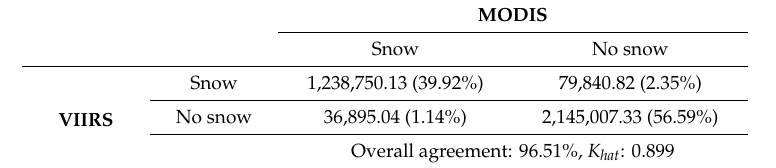
Table 4. Average confusion matrix between MYD10L2 and VSCMO.